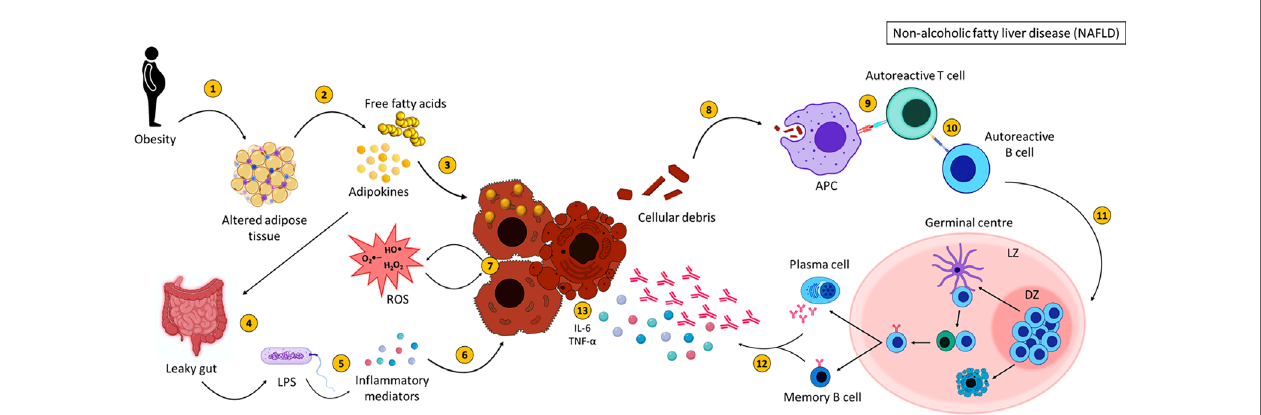
FIGURE 4 | Non-alcoholic fatty liver disease pathogenesis. NASH pathogenesis is linked to obesity and altered adipose tissue distribution (1). Adipose tissue releases adipokines and free fatty acids (FFA) (2), which result in lipid accumulation within the liver (3) and affect intestinal permeability (4). This allows bacterial translocation of LPS and other gut-derived pathogens (5) resulting in the secretion of in fl ammatory mediators which could damage hepatocytes (6). FFA, adipokines, ROS and in fl ammatory mediators injure hepatocytes (7) resulting in the expulsion of cellular debris. Self-antigens are engulfed by antigen presenting cells (8) and presented to autoreactive T cells (9), which stimulate autoreactive B cells (10). Activated B cells then migrate to secondary lymphoid tissues and undergo germinal centre reactions (11), where B cells with increased af fi nity receptors differentiate into memory B cells and PCs (12). The secretion of pro-in fl ammatory mediators (interleukin-6 and tumour necrosis factor alpha) (120) and autoantibodies from memory B cells and PCs further damage hepatocytes (13). Created with